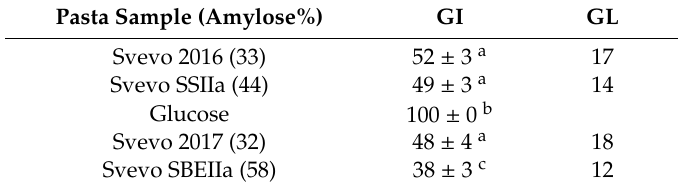
Table 7. Glycaemic index (GI) and glycaemic load (GL) of the reference food and the two pasta